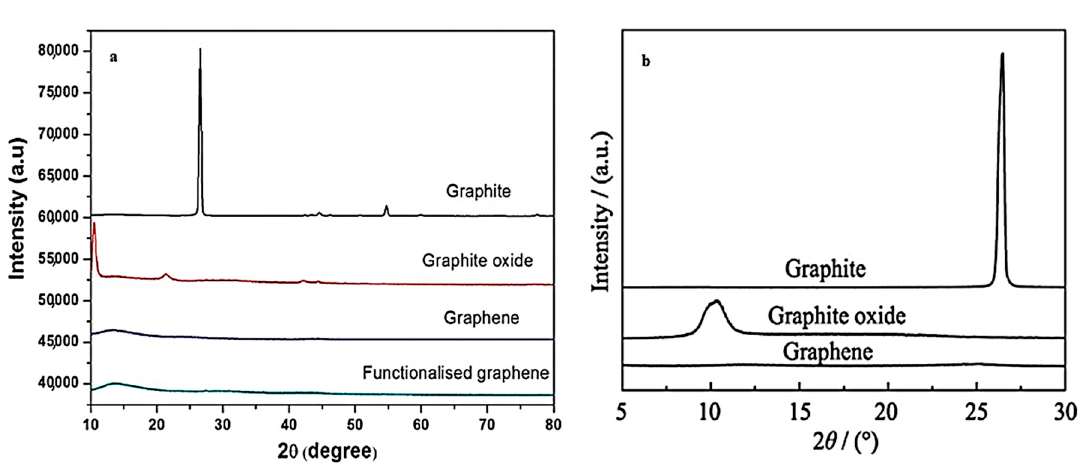
Figure 12. ( a ) XRD pattern for Functionalized Gp, Gp, GO, and Gr, ( b ) XRD plots of Gp, GO, and natural Gr. Reprinted with permission from [60]. Copyright RSC Publishers, 2017.